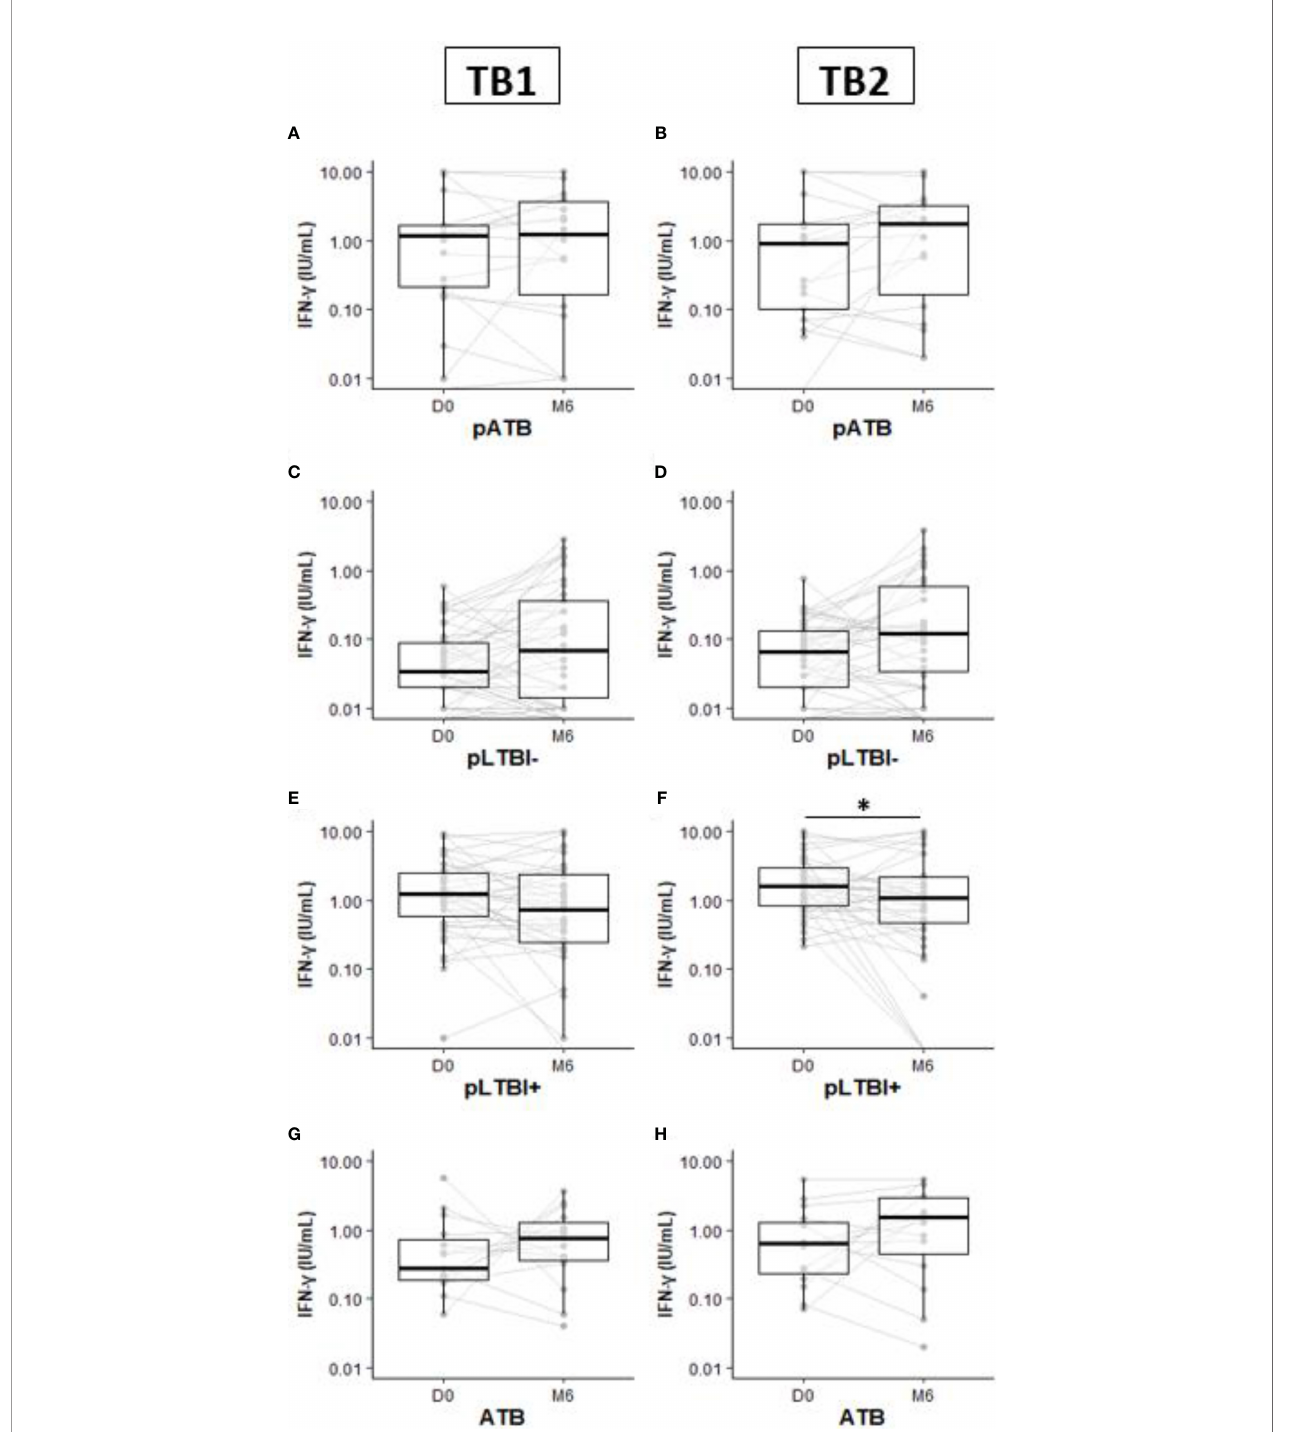
FIGURE 2 | Comparison of IFN- g production response by QuantiFERON-TB Gold-Plus Assay within pregnant and non-pregnant women subgroups pATB (A , B) , pLTBI- (C , D) , pLTBI+ (E , F) , and ATB (G , H) between inclusion (D0) and the 6-month follow-up visit (M6). Symbols indicate individual IFN- g values. Boxes indicate median values. Wilcoxon paired test comparisons were calculated and shown as *p < 0.05. DO, inclusion; M6, six months follow up visit; pATB, TB-con fi rmed pregnant women; ATB, TB-con fi rmed non-pregnant women; pLTBI-, pregnant women with QFT-P negative response; pLTBI+, pregnant women with QFT P positive